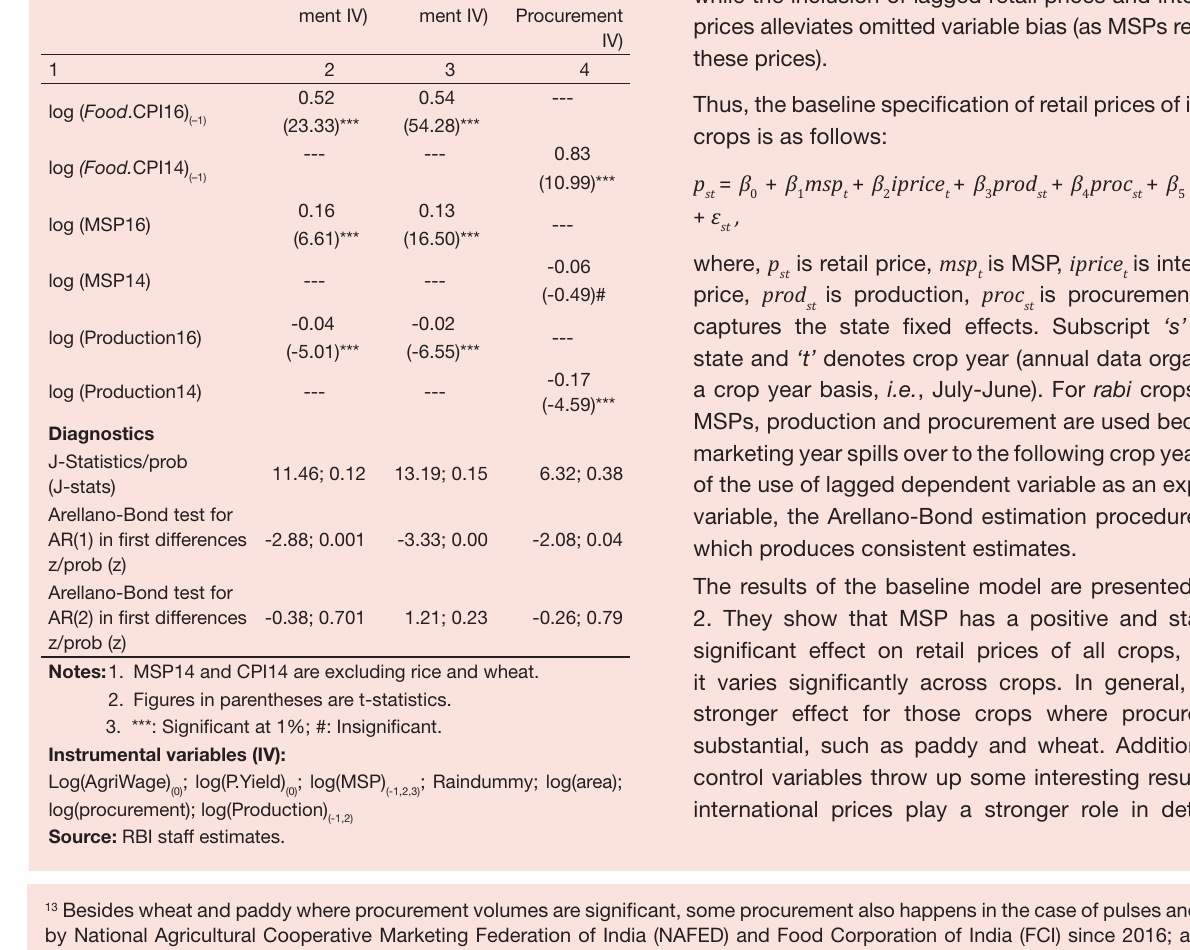
Table 1: empirical Results of the Dynamic Panel Data model (16 crops with mSP; 2011-12 to 2017-18) Explanatory Variables Scenario – I (CPI16